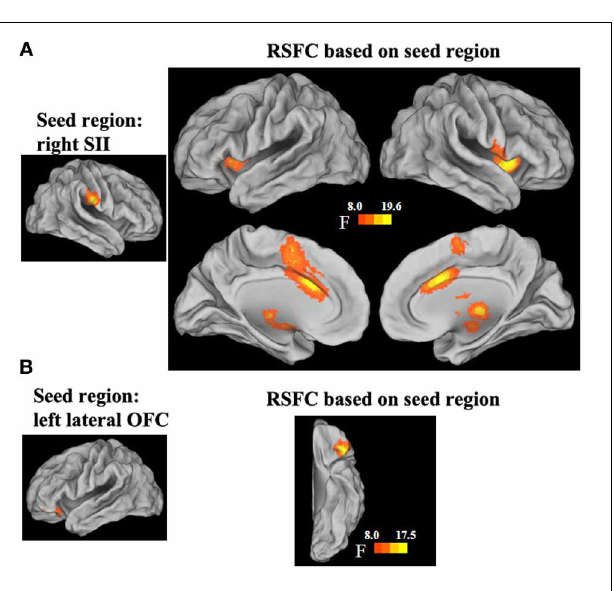
FIGURE 4 | Sex by GRP interaction effect in the strength of the functional connectivities of the right SII (A) and left lateral OFC. (B) seed